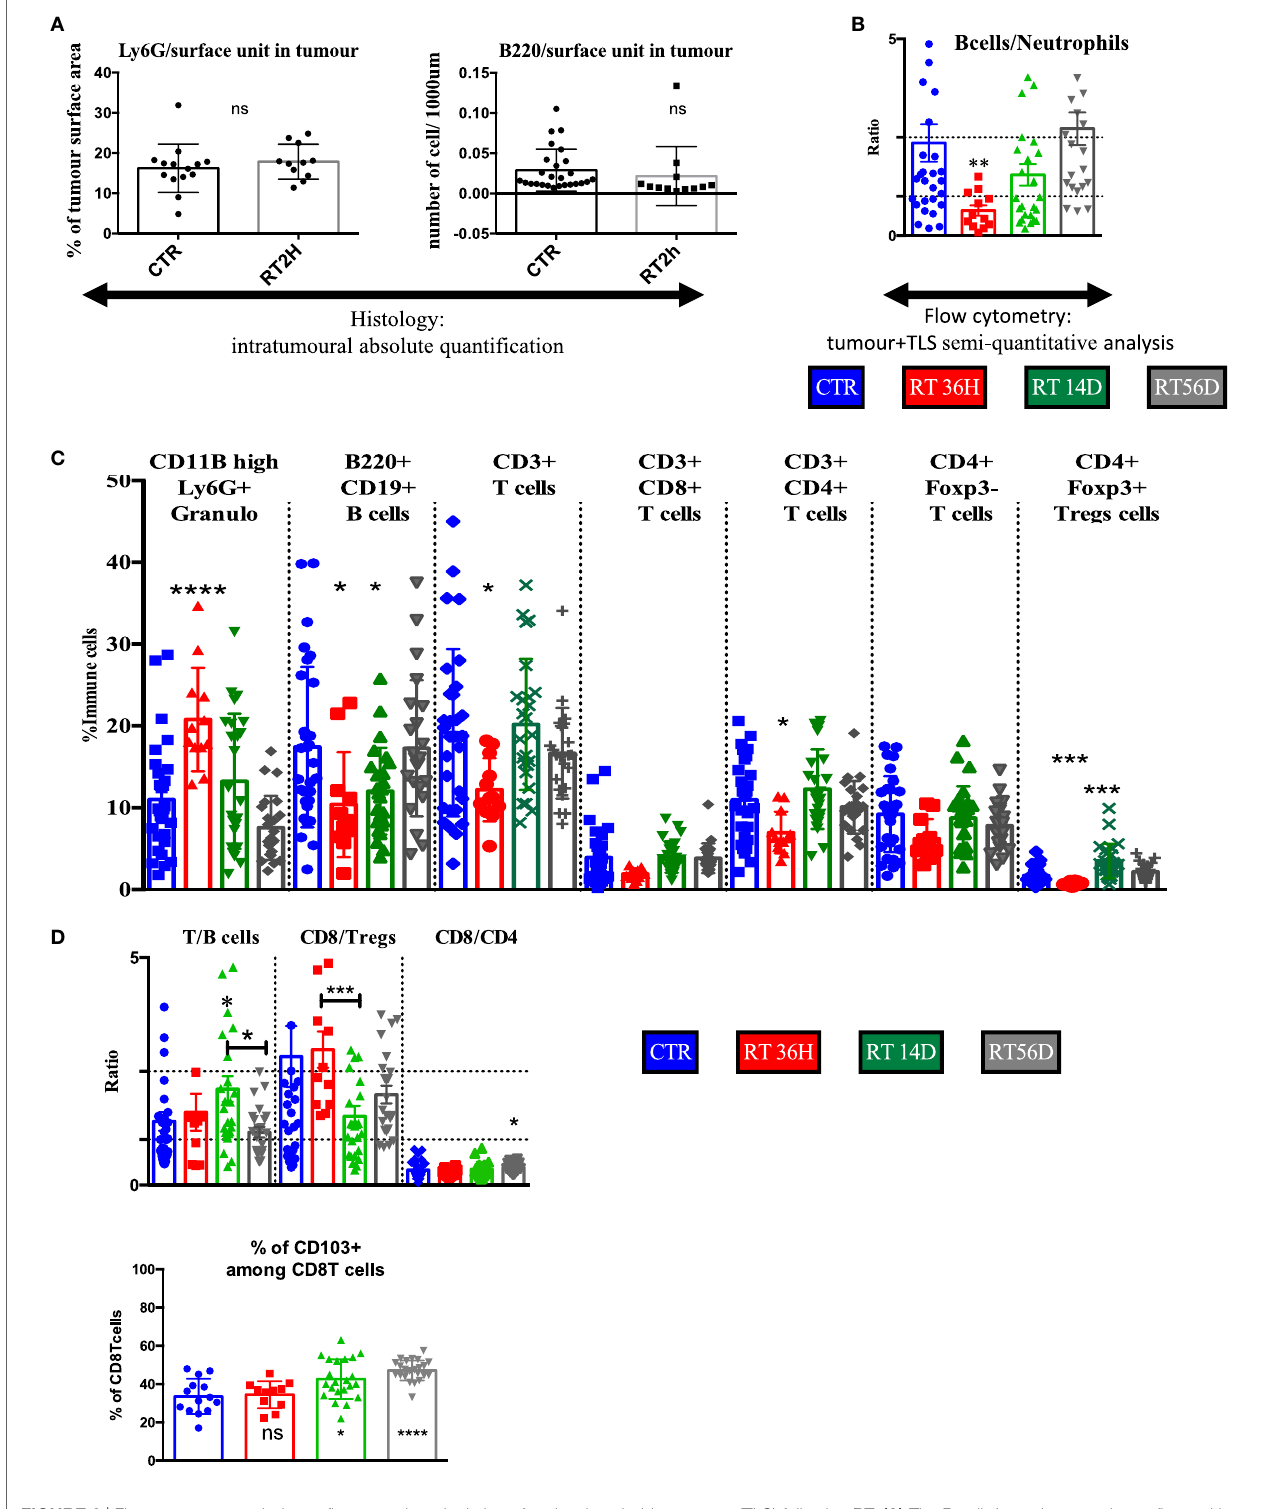
FigUre 6 | Flow cytometry analysis confirms transient depletion of tertiary lymphoid structures (TLS) following RT. (a) The B cells/granulocyte ratio confirms with histological analysis of the TLS depletion (B) . Tumor + TLS lymphoid and granulocytes variations are presented in % of whole immune cells analyzed after macrodissection (c) . T/B cells, CD8/Tregs, and CD4/CD8 ratio (D) . Numeration of CD103 positive cells amongst CD8 cells (e)